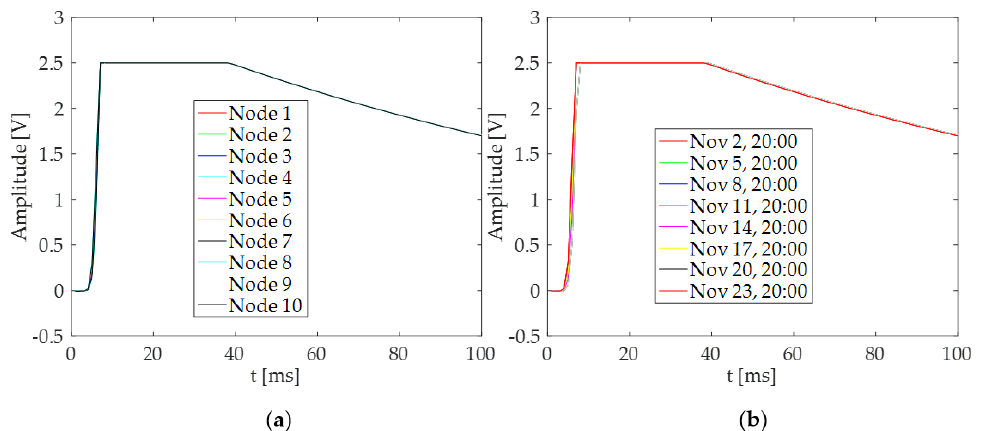
Figure 13. The results of the synchronization stability test with ( a ) the time synchronization stability varying in different nodes and ( b ) the time synchronization stability varying with time.